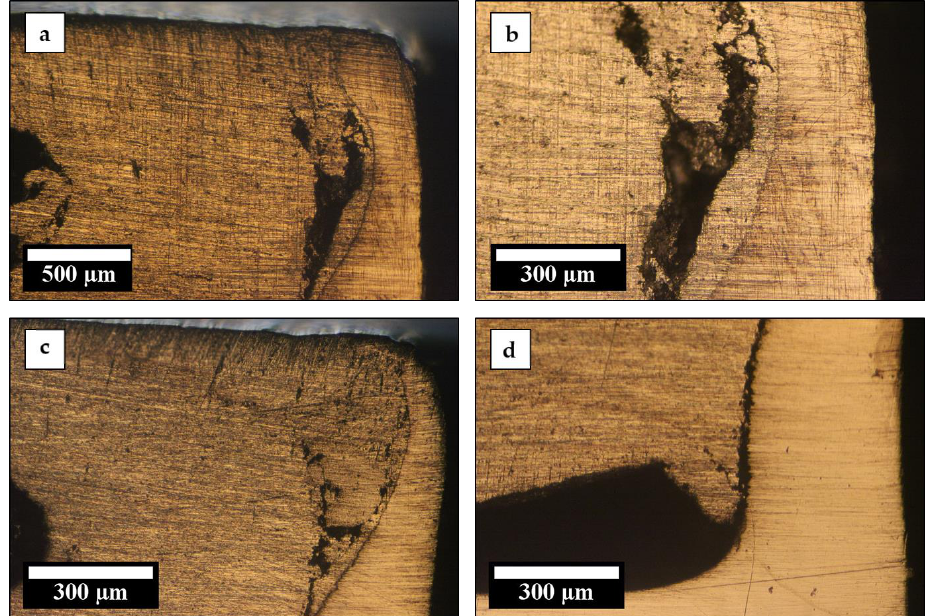
Figure 21. Optical image of the formed-joint zone under improvement condition. ( a ) back-extruded of the softened materials. ( b ) formed-joint region. ( c ) high-magnified view of formed-joint region. ( d ) materials stirring in bushing region.